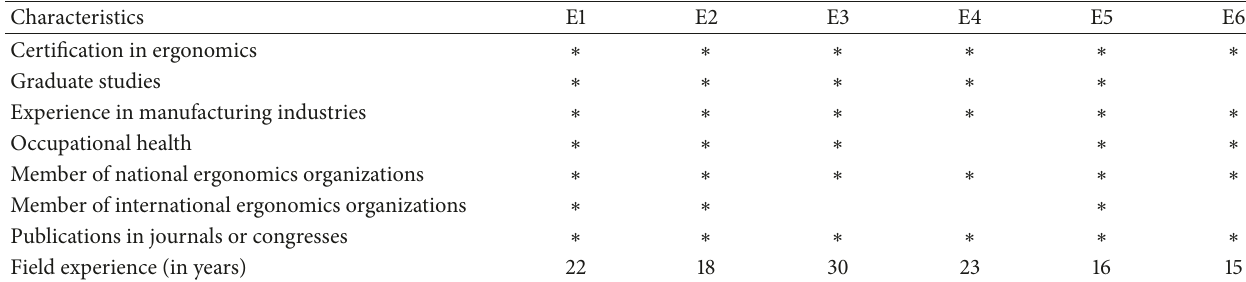
Table 2: Characteristics of the experts